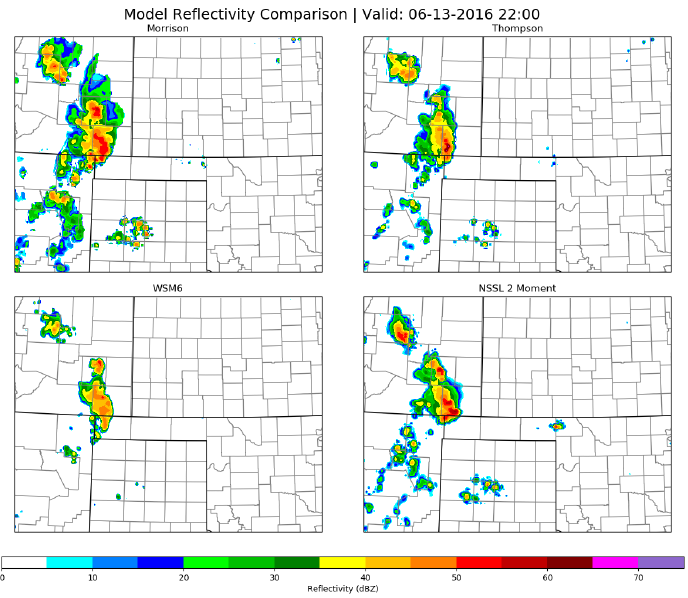
Figure 6. WRF simulated lowest model level reflectivity for a MCS event occurring 13 June 2016 five hours after convective initiation. Images are 10-h WRF forecasts valid at 2200 UTC.